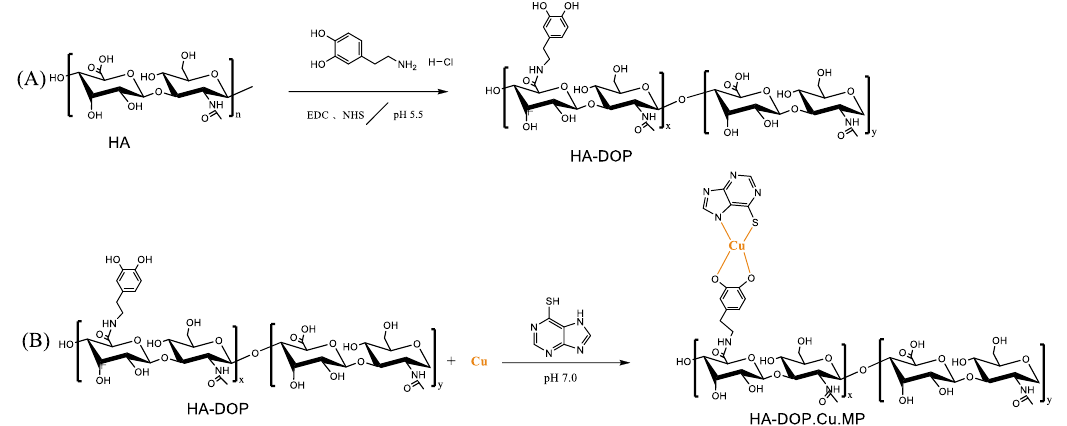
Figure 1. ( A ) Synthesis scheme of dopamine-modified hyaluronic acid (HA-DOP) via 1-(3-Dimethylaminopropyl)-3-ethylcarbodiimide hydrochloride/ N -hydroxysuccinimide (EDC/NHS) coupling chemistry. ( B ) Synthesis scheme of HA-DOP-Cu-MP coordination polymers via a coordination reaction.